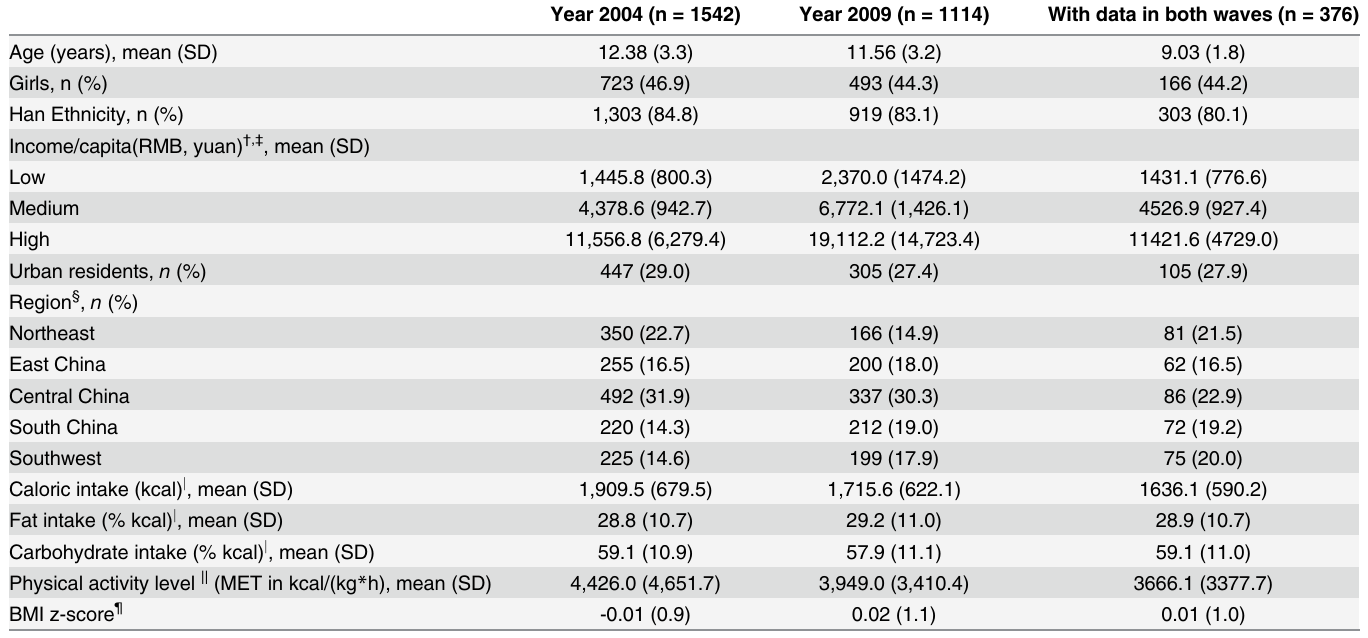
Table 1. Socio-demographic characteristics of children aged 6 – 17 years in nine provinces in China: China Health and Nutrition Survey 2004 – 2009 (cross-sectional